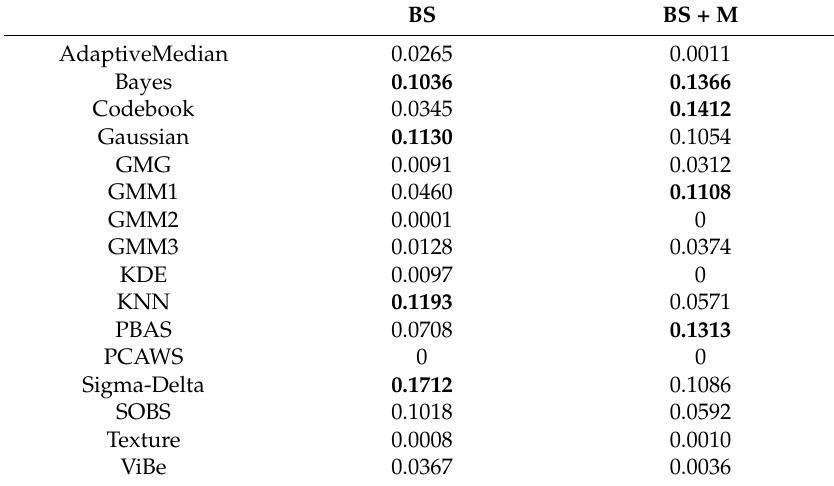
Table 20. Average F-m s of Sequence_5 and Sequence_6 detected by the evaluated BS